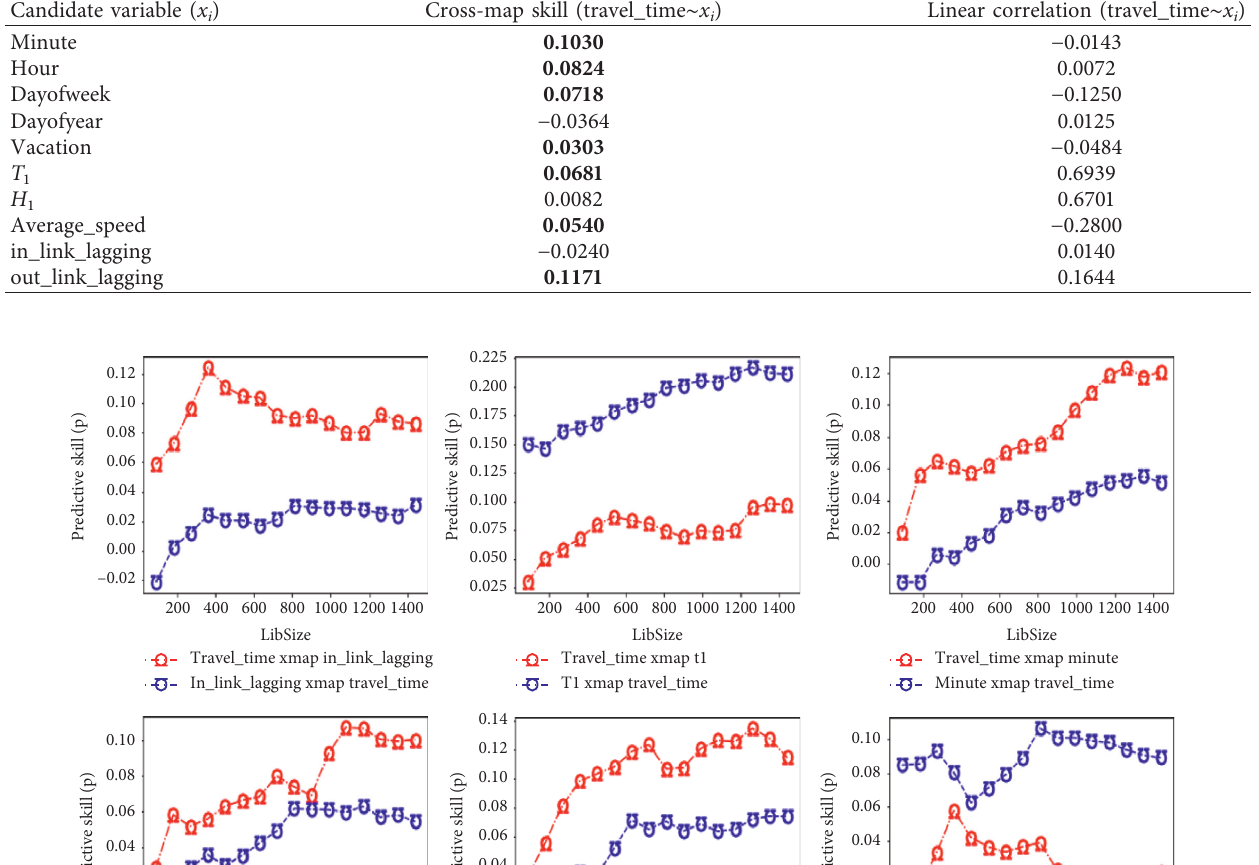
Table 2: CCM test of external driving factor and its correlation with target variables.